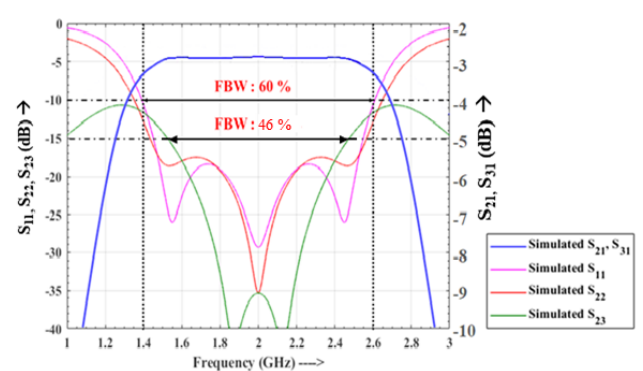
Figure 9. Simulated S-parameters for θ c = 60 ◦ .